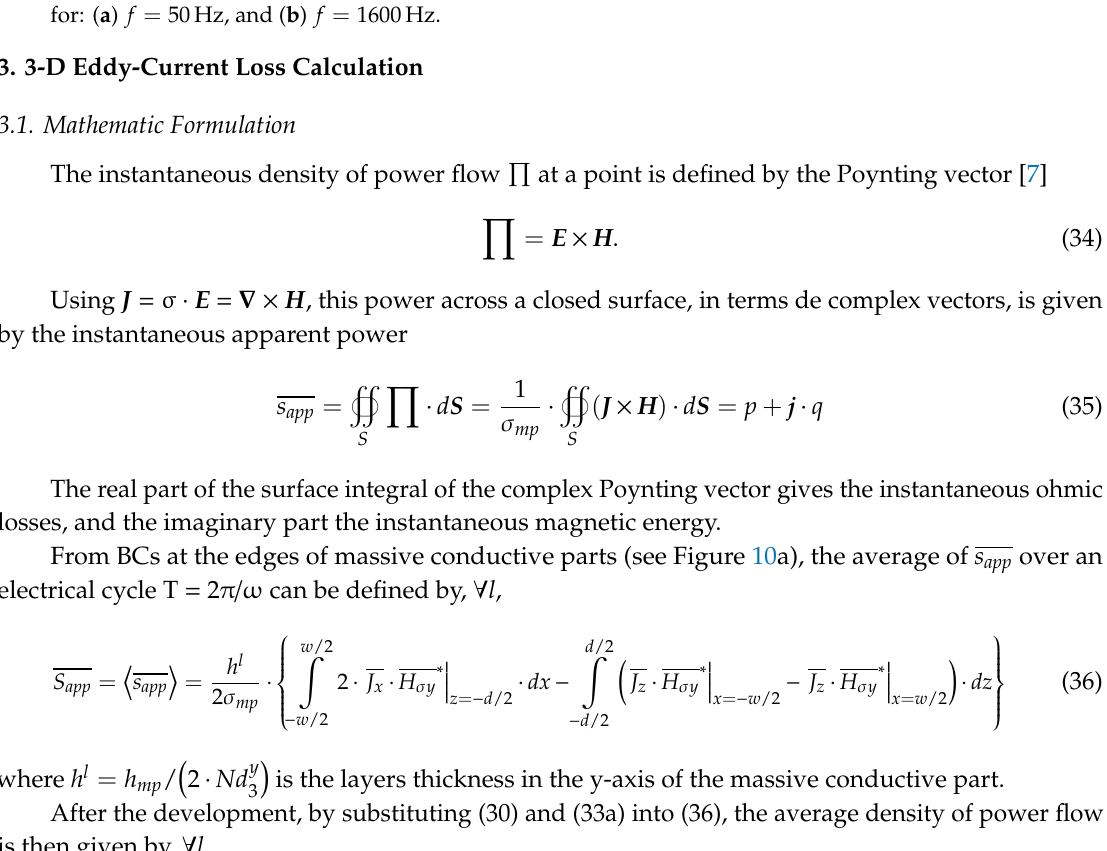
7.78 I at = 0 s t and max